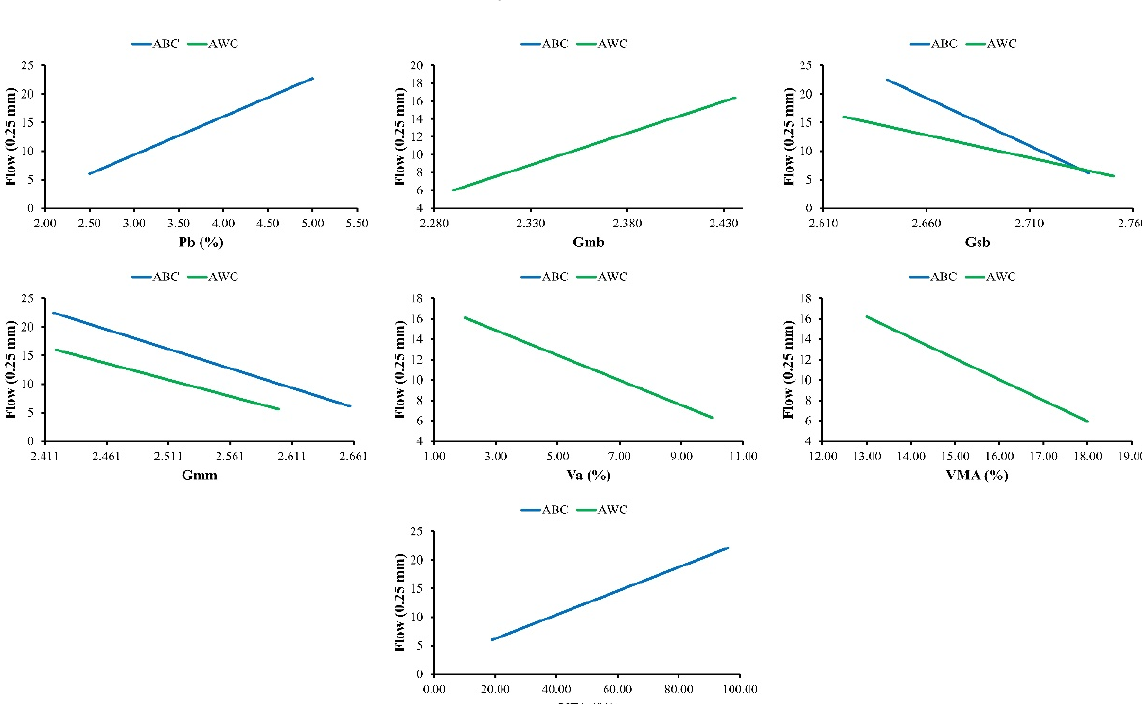
Figure 10. Parametric analysis of MF–ABC–AWC.